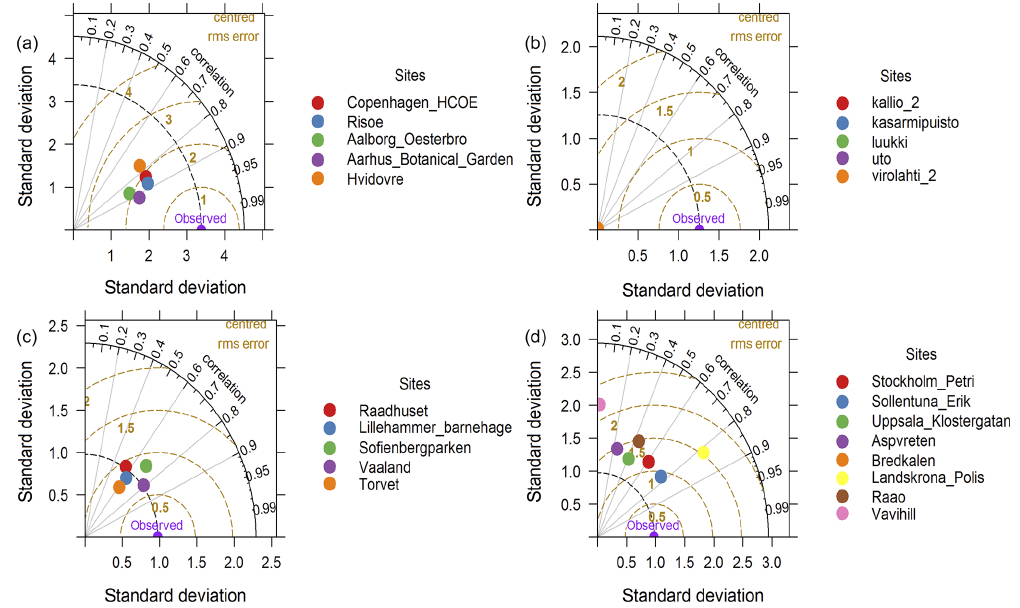
Figure 3. Taylor diagrams for daily mean PM 2 . 5 for all stations in (a) Denmark, (b) Finland, (c) Norway and (d)